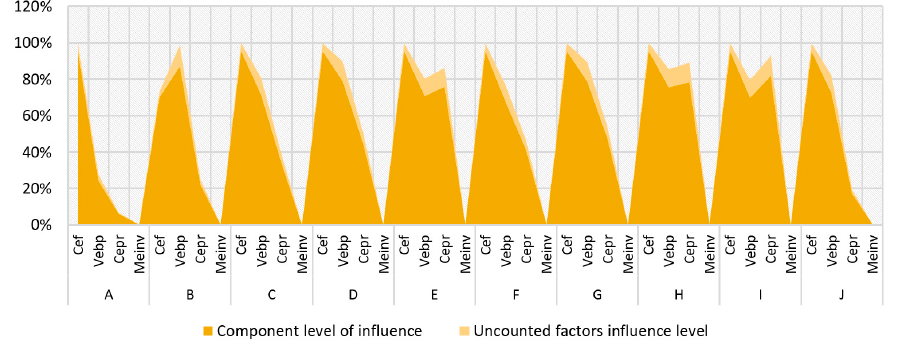
Figure 2. The level of influence of factors included in the model (and those not included) on its performance in the companies under study. Source: generated by the authors.